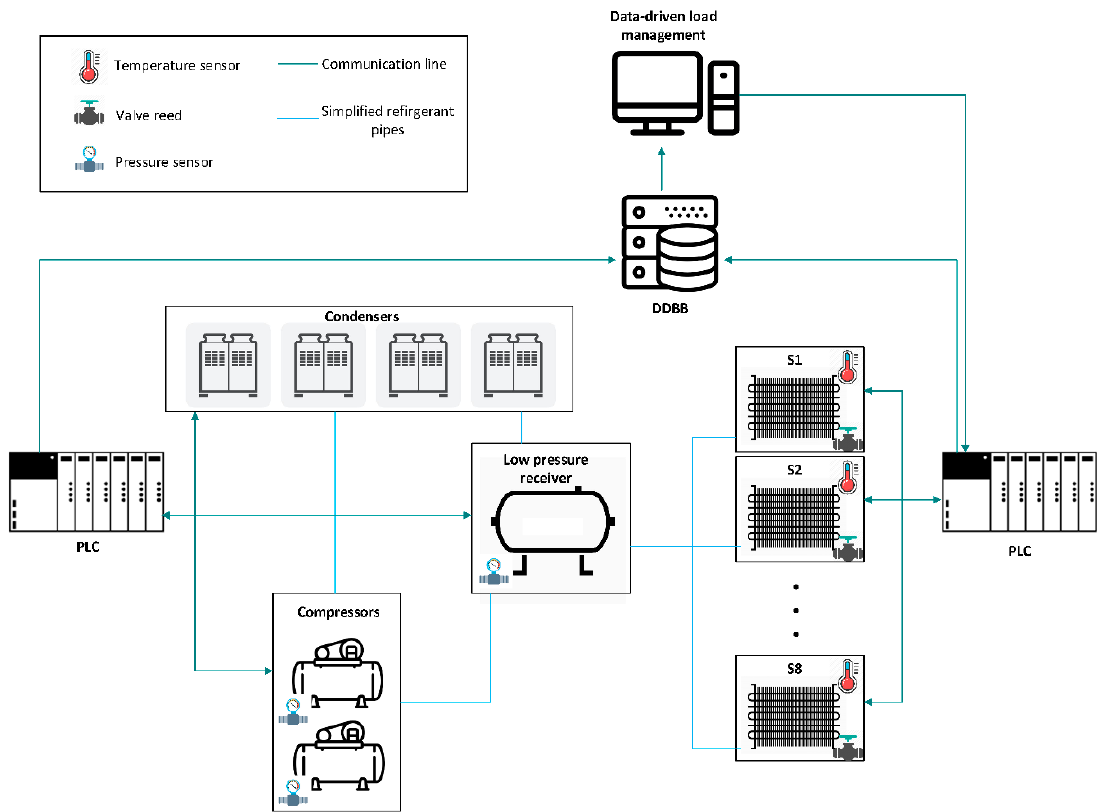
Figure 3. Simplified communication diagram of the refrigeration system. The data-driven load management block represents the proposed solution to manage the cooling loads.